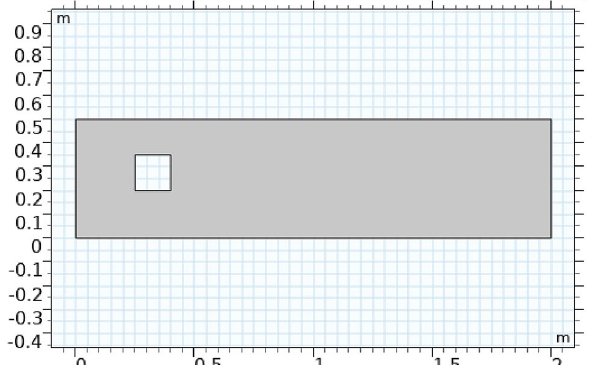
Figure 1. The sketch of the